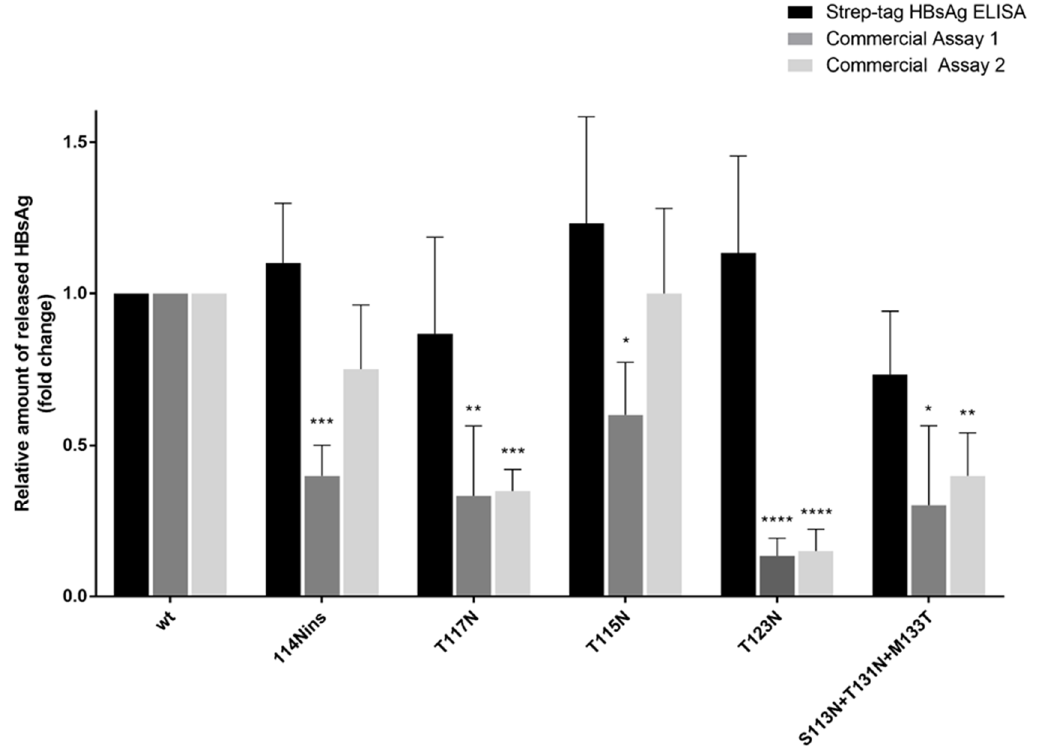
Figure 2. Impact of N -glycosylation on HBsAg antigenicity. Quantification of strep-tagged HBsAg released in the supernatants of Huh7 cell cultures by different assays is shown. Values are the mean ( ± SD) of three independent experiments each carried out in duplicate and expressed as relative amount compared to wt. The black bars show the Strep-tagged HBsAg quantified by an ELISA using antibodies targeting Strep-tag portion. The dark and light grey bars report the Strep-tagged HBsAg quantified with commercial assays (thus, using antibodies targeting the major hydrophilic region of HBsAg). Statistically significant differences in the amount of extracellular Strep-tagged HBsAg between each mutant and wt were assessed by Student’s T-test. * p < 0.05, ** p < 0.01, *** p < 0.001, **** p < 0.0001